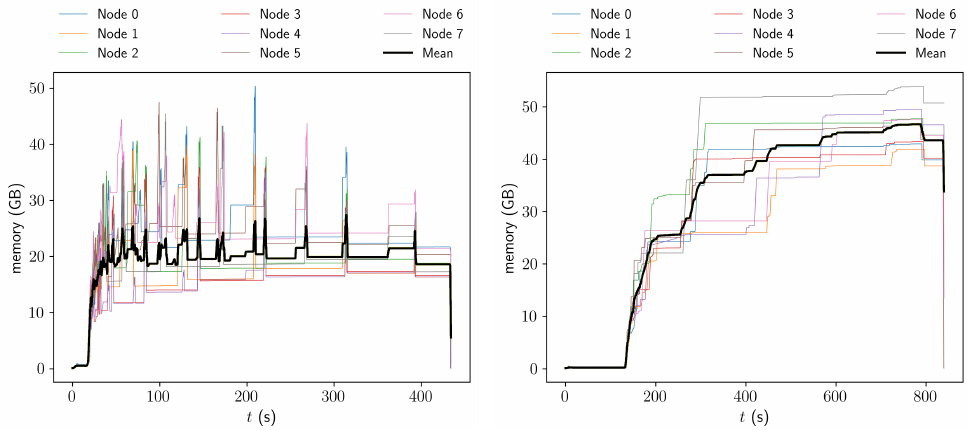
Figure 3: Total memory reported by the operating system of two sample runs using STRUMPACK (a) and MUMPS (b) for a L = 22 system. Thin lines correspond to the total memory used on individual nodes, while the thick black line is the average over all